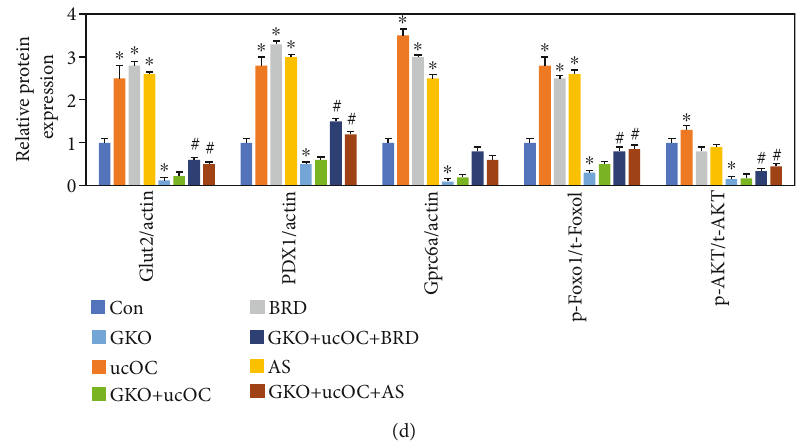
Figure 6: Knockdown of Gprc6a or suppression of PI3K/AKT signal pathway could reverse the upregulation of GPRC6A/PI3K/AKT/ FoxO1/Pdx1 caused by ucOC. (a) The protein expression of Gprc6a, Glut2, AKT, FOXO1, and Pdx1 was measured through western blotting after treatment with PA, ucOC, and LY (the inhibitor of PI3K/AKT signal pathway). (b) The protein expression of Gprc6a, Glut2, AKT, FOXO1, and Pdx1 was analyzed. (c) The protein expression of Gprc6a, Glut2, AKT, FOXO1, and Pdx1 was measured through western blotting after treatment with ucOC, BRD (The inducer of Pdx1), and AS (The inhibitor of Foxi1). (d) The protein expression of Gprc6a, Glut2, AKT, FOXO1, and Pdx1 was analyzed. Compared with the control group, ∗ P < 0 : 05 . Compared with the GKO +ucOC group, # P < 0 : 05 . Compared with the ucOC group, + P < 0 : 05 . Compared with the PA +ucOC group, ∗∗ P < 0 : 05 . Beta-TC6 was used in these